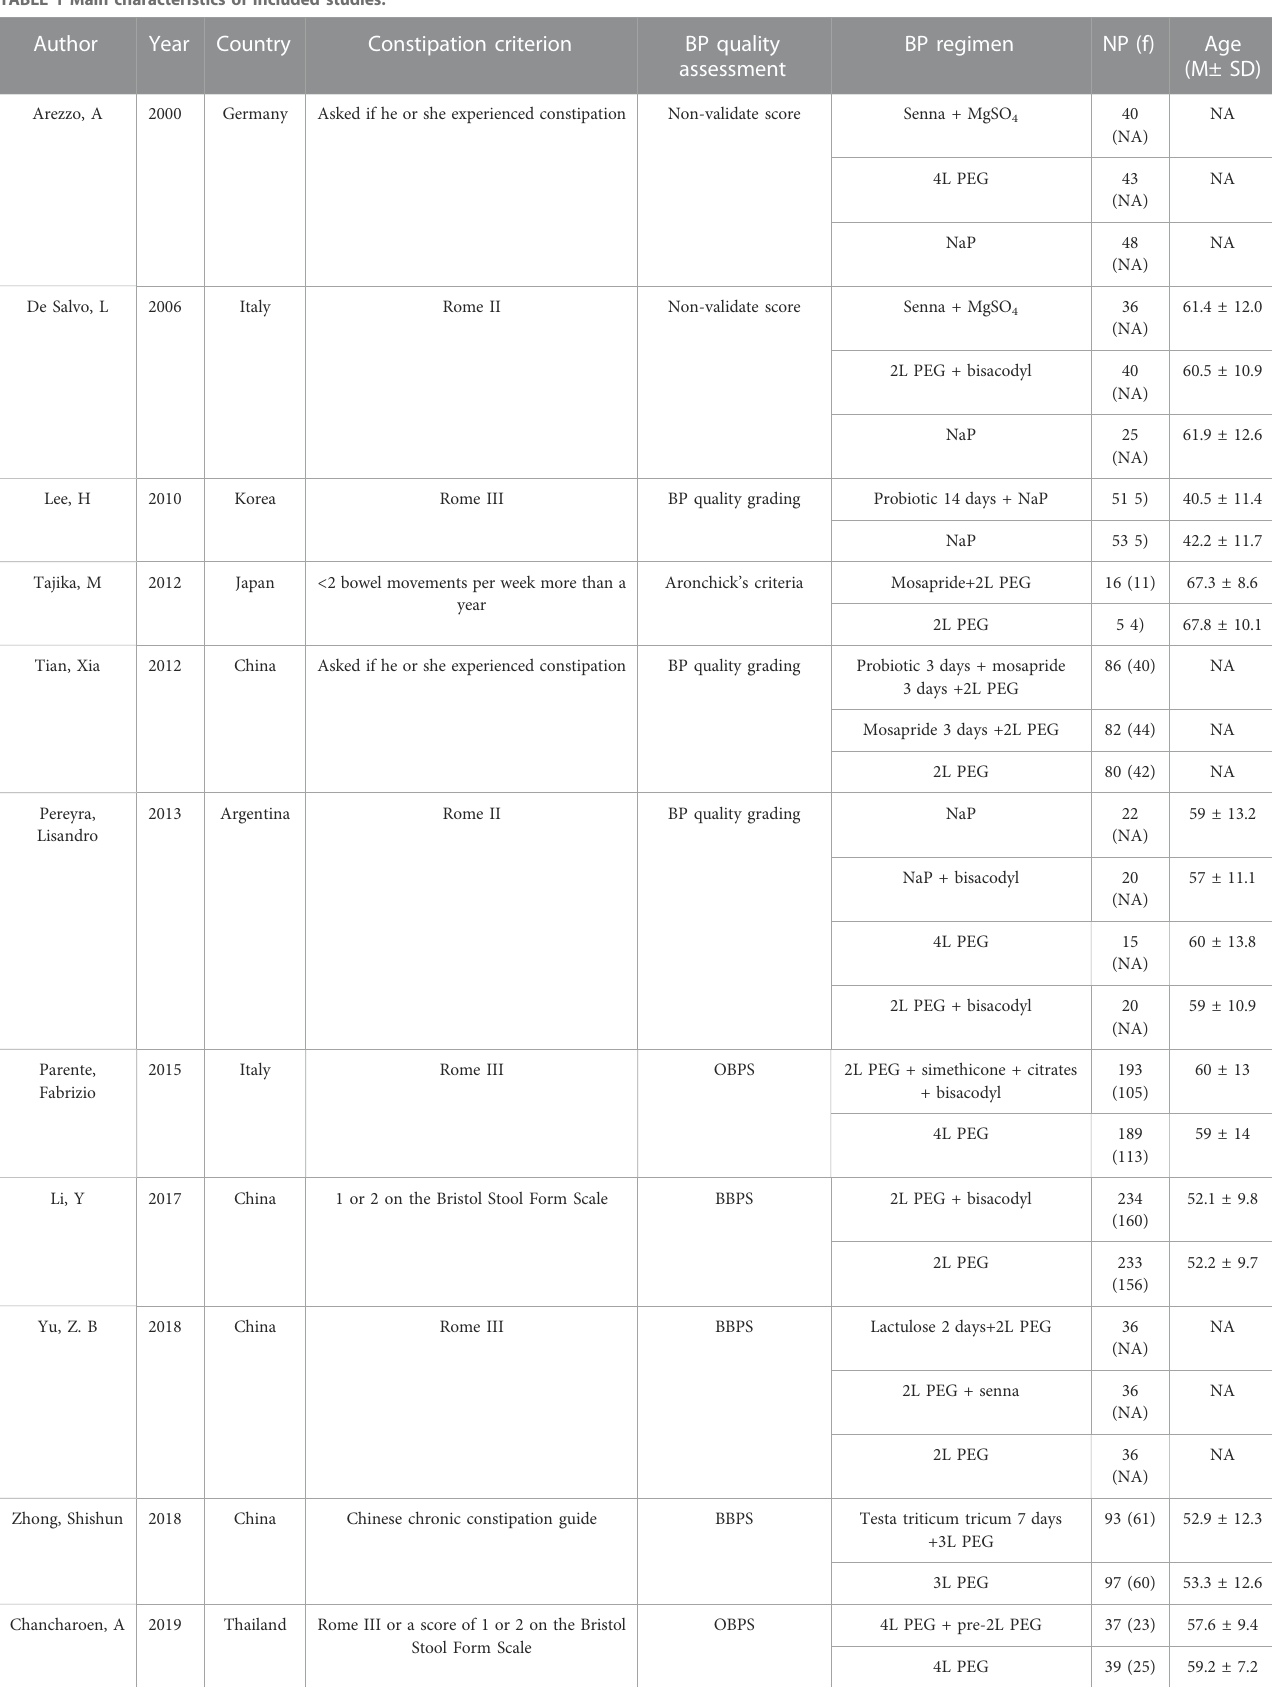
TABLE 1 Main characteristics of included